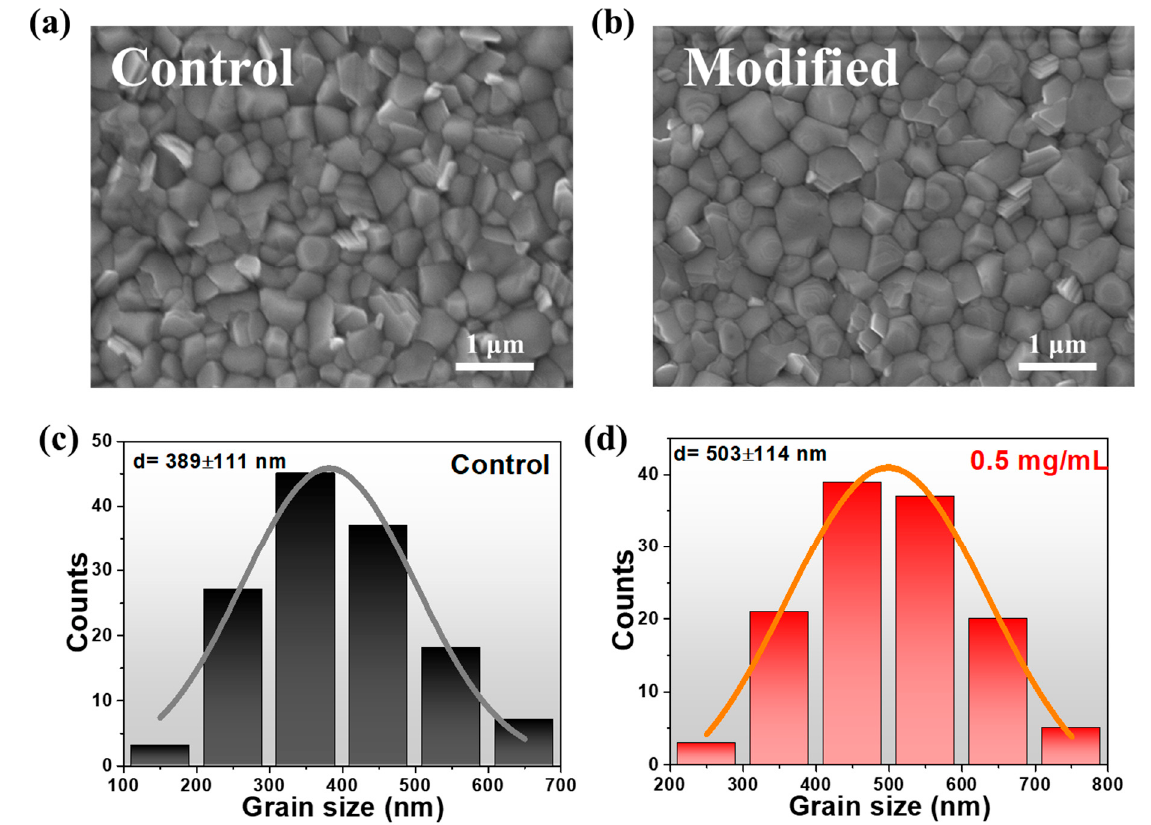
Figure 2. Top-view SEM images of control ( a ) and 1D/3D modified ( b ) perovskite films and corre- sponding statistical diagrams of crystallite size for control ( c ) and 1D/3D modified ( d ) perovskite film.